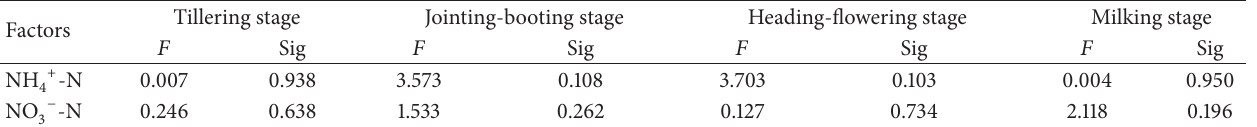
Heading-flowering